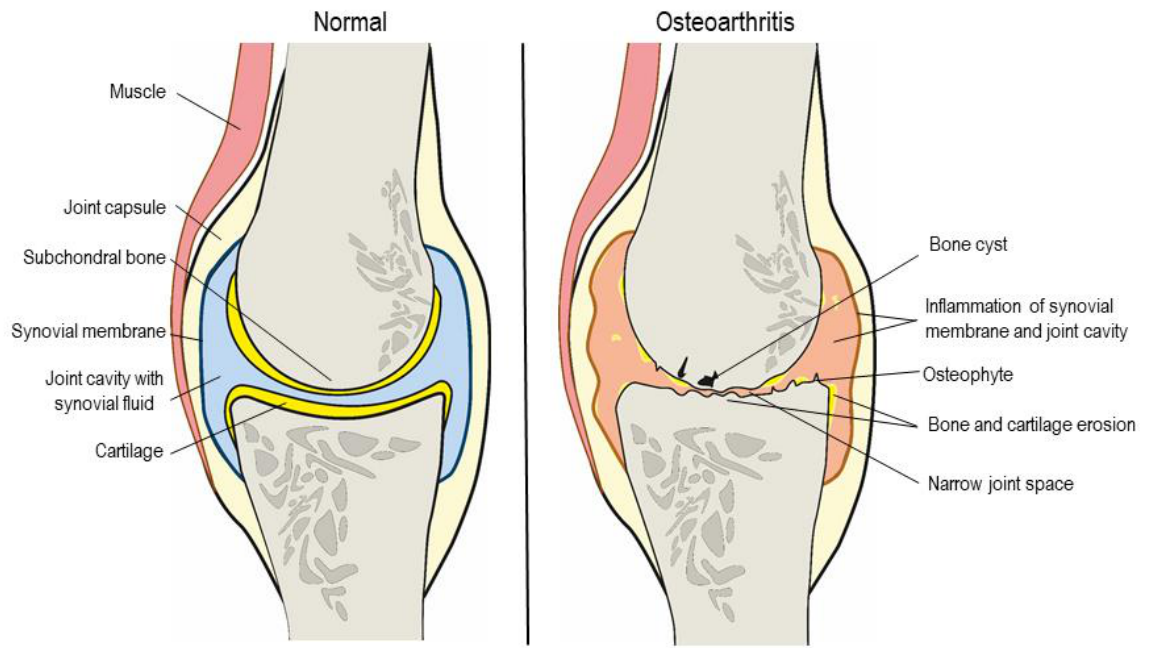
Figure 1. Schematic representation of the structural composition of a healthy and an osteoarthritic